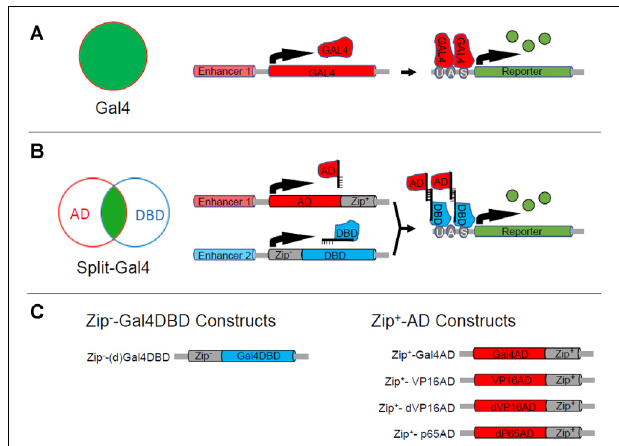
FIGURE 1 | The Split Gal4 system. (A) The binary Gal4-UAS expression system can be used to target the expression of a reporter or effector (green) to a group of cells (red circle) in which an enhancer (Enhancer 1) is active. As illustrated in the right-hand schematics, Enhancer 1 drives expression of the Gal4 transcription factor (red) which in turn drives expression of the reporter or effector gene (green), which is placed downstream of Gal4’s DNA binding site (UAS). (B) The Split Gal4 system uses two enhancers with activity in overlapping cell groups (red and blue circles) to target reporter or effector expression (green) to the intersection of the two groups. The intersectional logic of expression is shown schematically in the Venn diagram (left). The right-hand panels illustrate the transcriptional mechanisms: one enhancer (Enhancer 1) is used to target expression of the transcription activation domain (AD) of Gal4 or some other transcription factor fused to the Zip + leucine zipper, while the other (Enhancer 2) is used to target expression of the Gal4 DNA binding domain (Gal4DBD) fused to the Zip + leucine zipper. Association of Zip + and Zip + brings the GalDBD and AD components together to reconstitute Gal4 transcriptional activity and drive expression of UAS-transgenes. (C) Design of Zip − -Gal4DBD and Zip + -AD constructs. Two Zip − -Gal4DBD constructs have been made. They share the same sequence, but the one made by Pfeiffer et al. (2010; designated here as dGal4DBD) is codon-optimized for use in Drosophila and is placed behind a Drosophila synthetic core promoter. Activation domains from three different transcription factors have been used to make Zip + -AD constructs. Zip + -p65AD and Zip + -dVP16AD are codon-optimized and show strong, high-fidelity